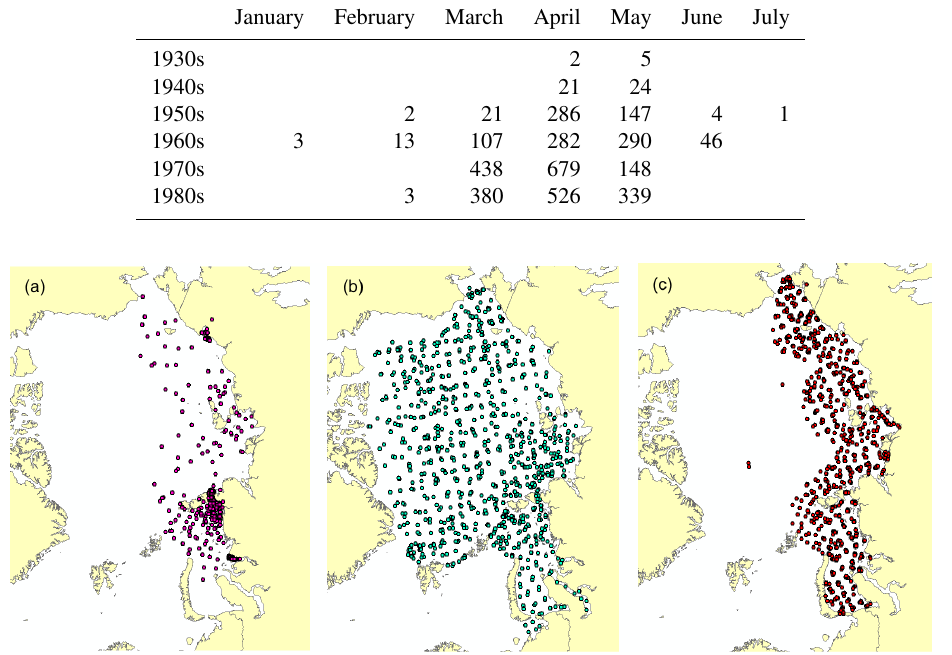
Figure 2. Sever expedition landings where snow measurements were conducted in the MAM months: 1960s (a) , 1970s (b) and 1980s (c) .